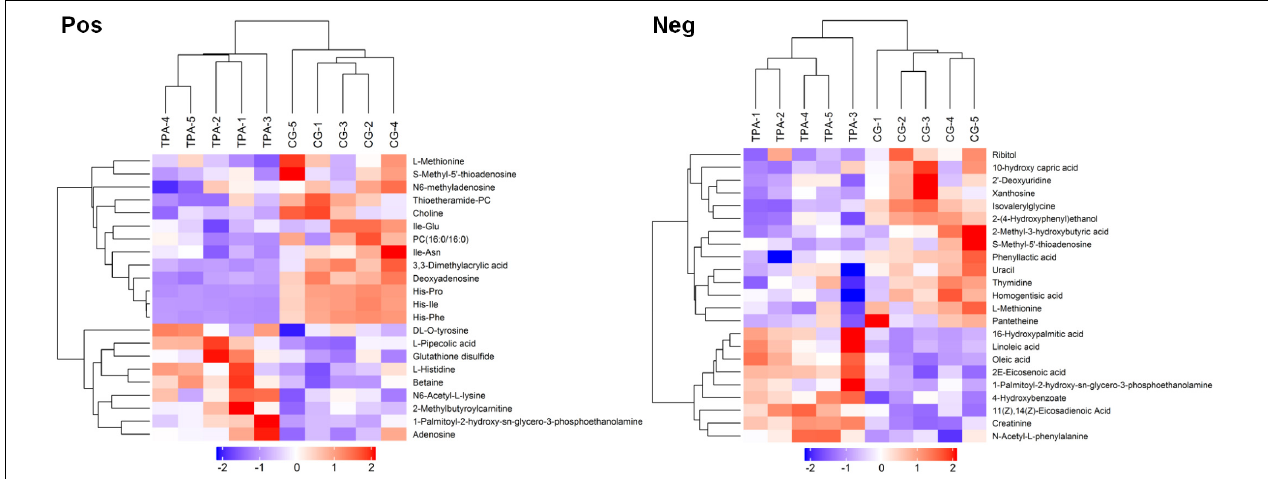
FIGURE 1 | Hierarchical clustering of differential metabolites in TPA-treated B. trispora. Pos, positive mode; Neg, negative mode; TPA, tripropylamine treated group; CG, control group. Red and blue indicate higher and lower levels of the metabolites scaled to mean and standard deviation of raw metabolites level, respectively.